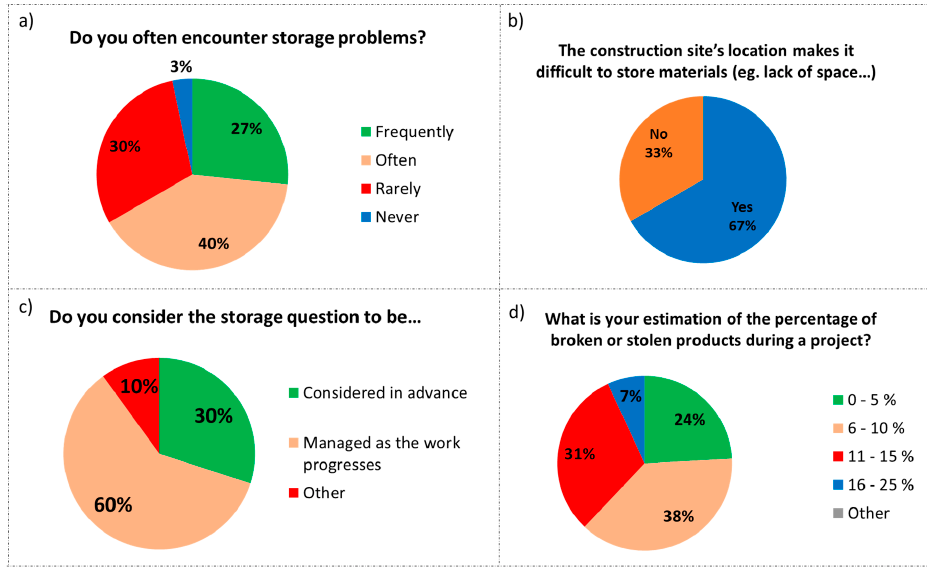
Figure 7. Questions for contractors related to on-site inventory.